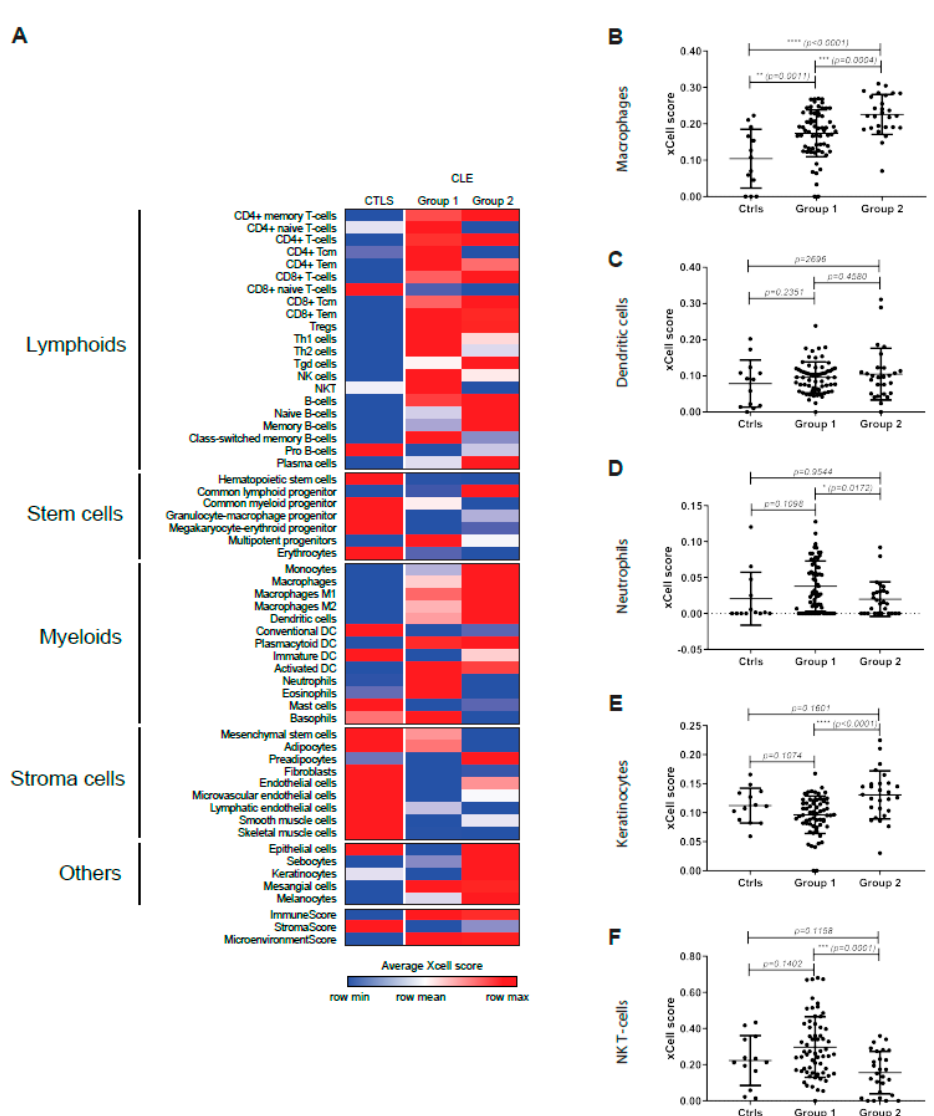
Figure 4. Cell type enrichment analysis using xCell tool. ( A ). Heatmap of relevant cell types representing average xCell score for each CLE subgroups compared to controls. ( B ). Graph of the macrophage xCell scores, showing a significantly higher score in CLE Group 2 compared to Group 1 and controls. ( C ). Graph of the dendritic cell xCell scores. ( D ). Graph of the neutrophil xCell scores, showing a significant lower score in CLE Group 2 compared to Group 1. ( E ). Graph of the keratinocyte xCell scores, showing a significant higher score in CLE group 2 compared to Group 1. ( F ). Graph of the NKT xCell scores, showing a significant higher score in CLE Group 1 compared to Group 2. For (B–F), comparisons were made via unpaired Students’ t -test.